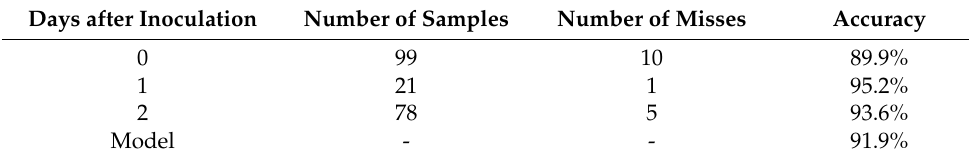
Table 11. A summary of all approaches and their results . Table 10. Results of a dataset with days 0, 4, 5, 6, 7 after inoculation (Exp3b). Days after